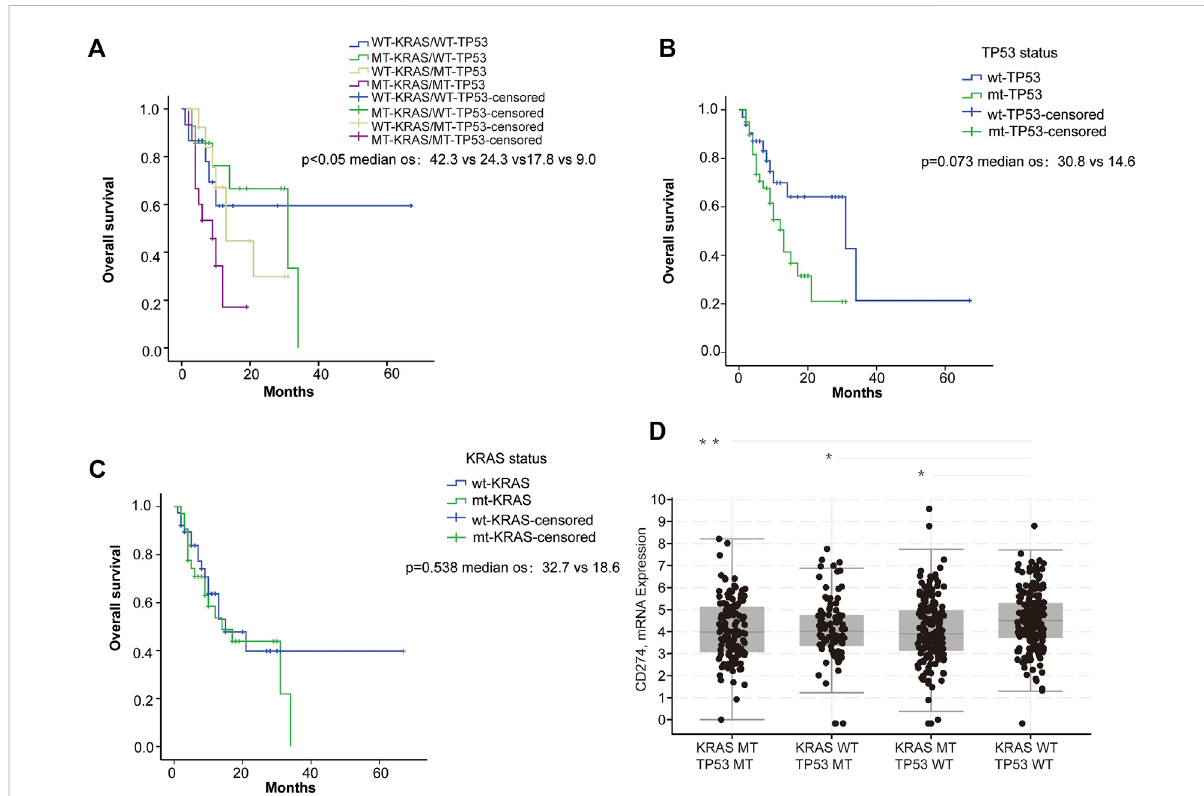
FIGURE 1 PD-L1 expression was associated with KRAS and TP53 status. (A – C) Survival analysis of ICI-treated CRC samples ( n = 60): (A) Survival analysis wasusedtocompareoverallsurvivalamongthefoursubgroupsdi-videdbasedonKRASandTP53mutationstatus. (B) Survivalwasusedtocompare overallsurvivalbetweenthewild-typeandthemutantTP53samples; (C) Survivalanalysiswasusedtocompareoverallsurvivalbetweenthewild-type and the mutant KRAS samples. (D) Analysis of the TCGA colorectal samples ( n = 594) comparing the differences in CD274 (PD-L1) mRNA expression. * p < 0.05; ** p <